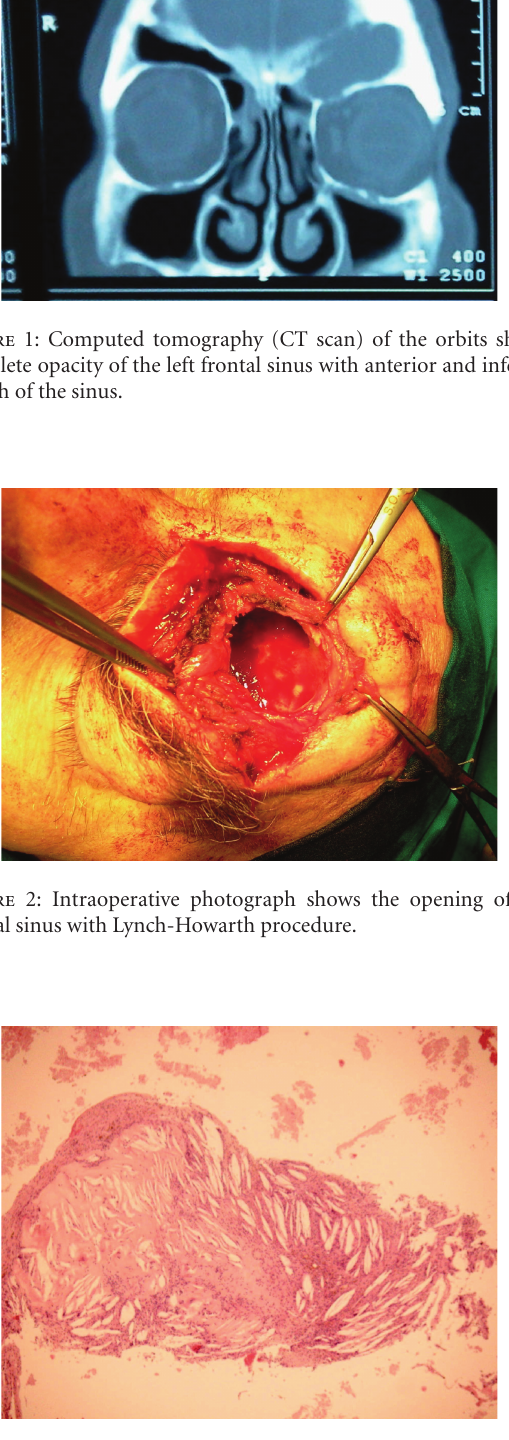
Figure 3: A histology slide of the cholesterol granuloma of the frontal sinus reported here. The fibrous connective tissue contains the characteristic “needles” of cholesterol surrounded by multinucleated foreign body giant cells (hematoxylin-eosin, original magnification × 50).